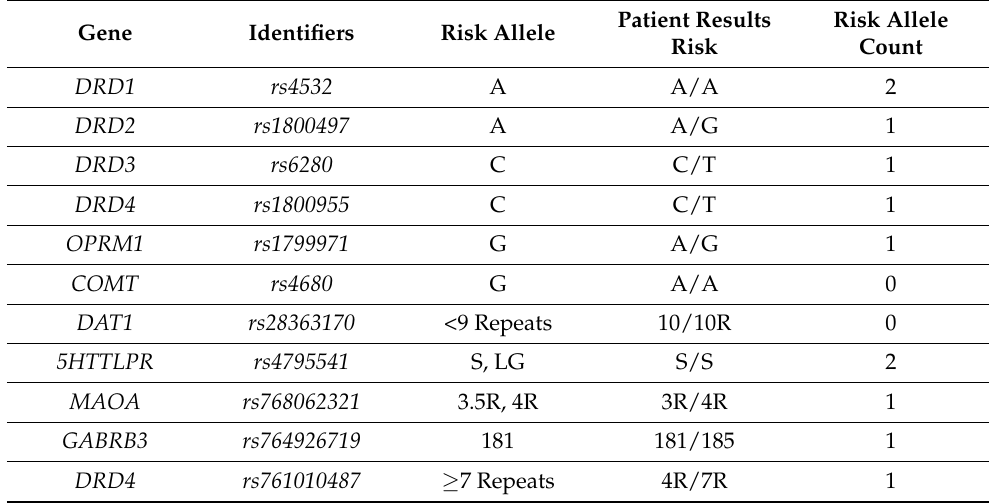
Table 11. Son’s GARS test results *.